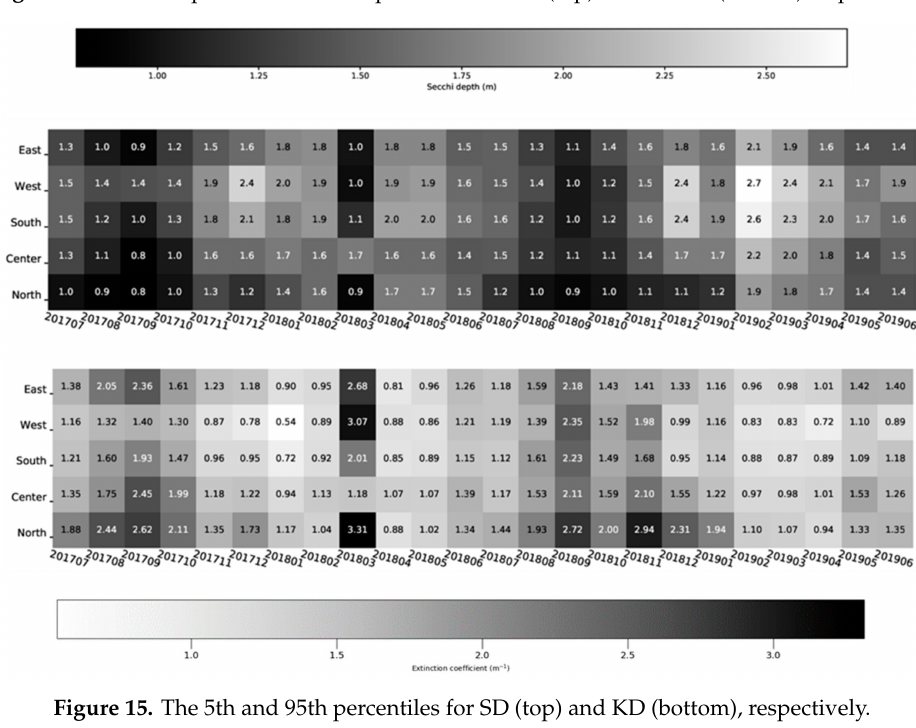
Figure 14. The 95th percentile and 5th percentile for SD (top) and for KD (bottom) respectively.